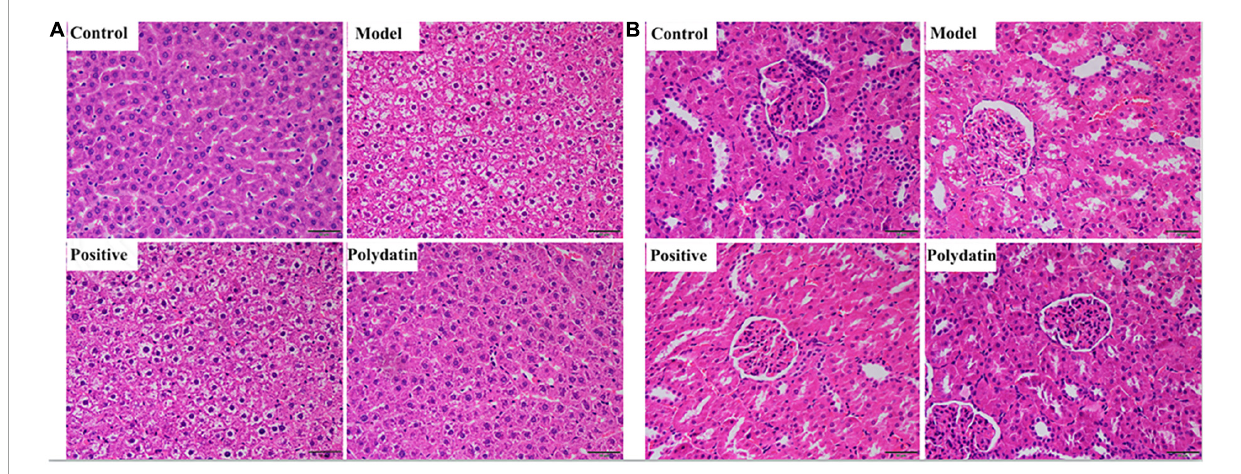
FIGURE2 Histopathological evaluation of rat liver (A) and kidney (B) in different treatment groups. Scale bar = 100 µ m.